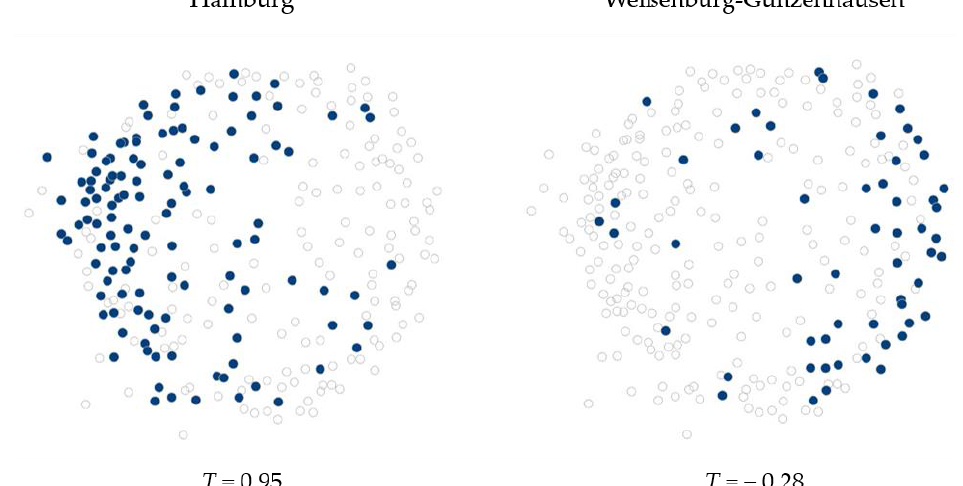
Figure 2. Comparison of two German labor market regions (LMRs). The subnetworks locations of Hamburg and Weißenburg-Gunzenhausen are shown within the 2007 German industry network of Figure 1. Qualitatively, the density of Hamburg nodes is higher than those of Weißenburg-Gunzenhausen. We quantify this visually intuitive difference in a regional tightness metric T . Links have been removed for clarity.